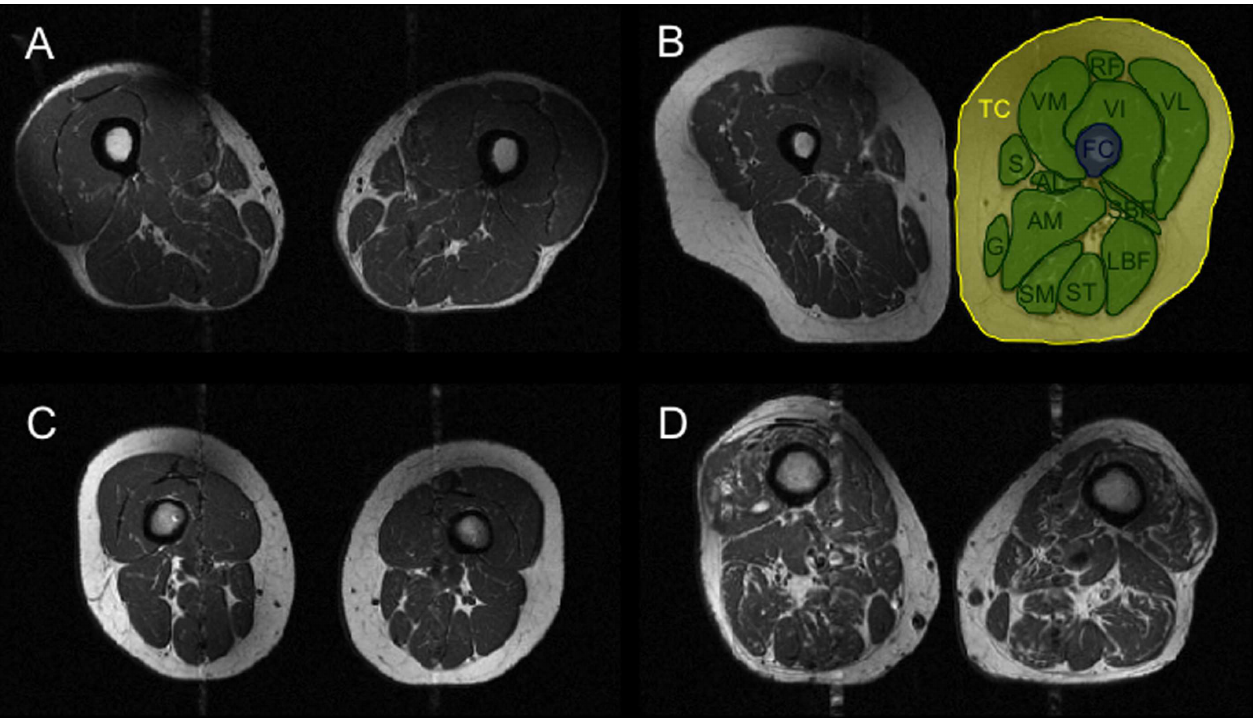
Fig 1. Segmentation on axial T1-w images of the thigh. Segmentation was performed for the vastus medius (VM), intermedius (IM) and lateralis (VL), rectus femoris (RF), sartorius (S), gracilis (G), adductormagnus (AM), adductor longus(AL), short head of biceps (SBF), long head of biceps (LBF), semitendinosus (ST), semimembranosus (SM), total thigh circumference (TC) and femur circumference (FC). Examplesare given of four different individuals. (A) high muscle volume, high muscle/ fat ratio. (B) high muscle volume, small muscle/ fat ratio. (C) small muscle volume. (D) high fatty infiltrationof thigh